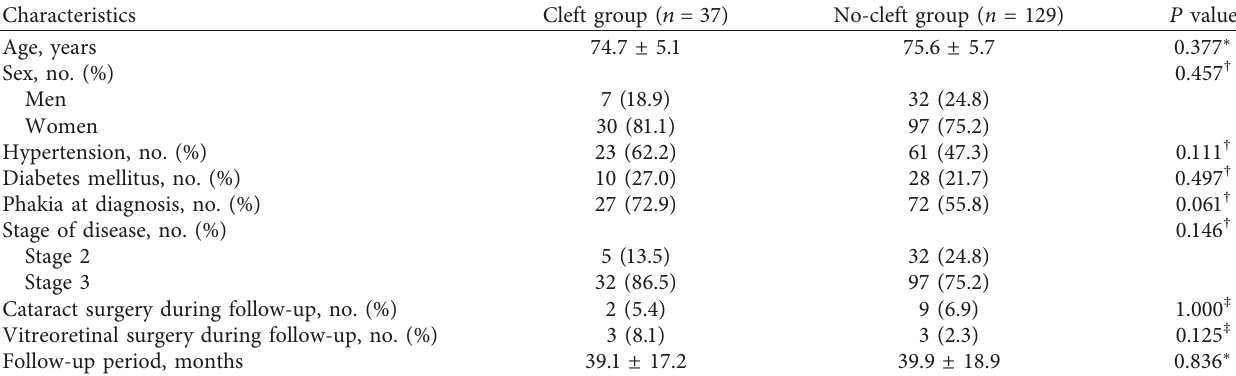
Table 1: Comparison of characteristics between the cleft group and the no-cleft